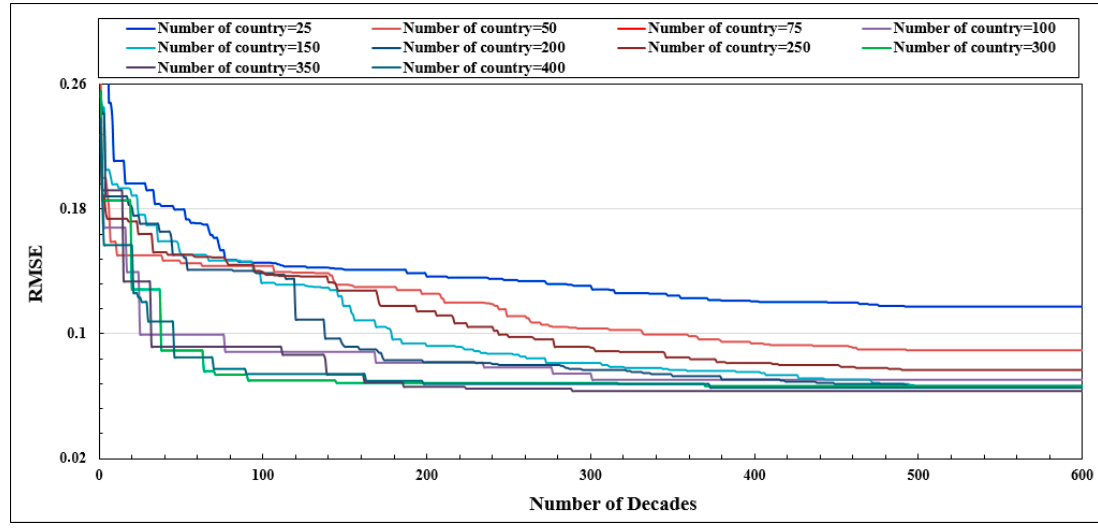
Figure 6. Performance of ICA-ANN models with different Ncountry values.